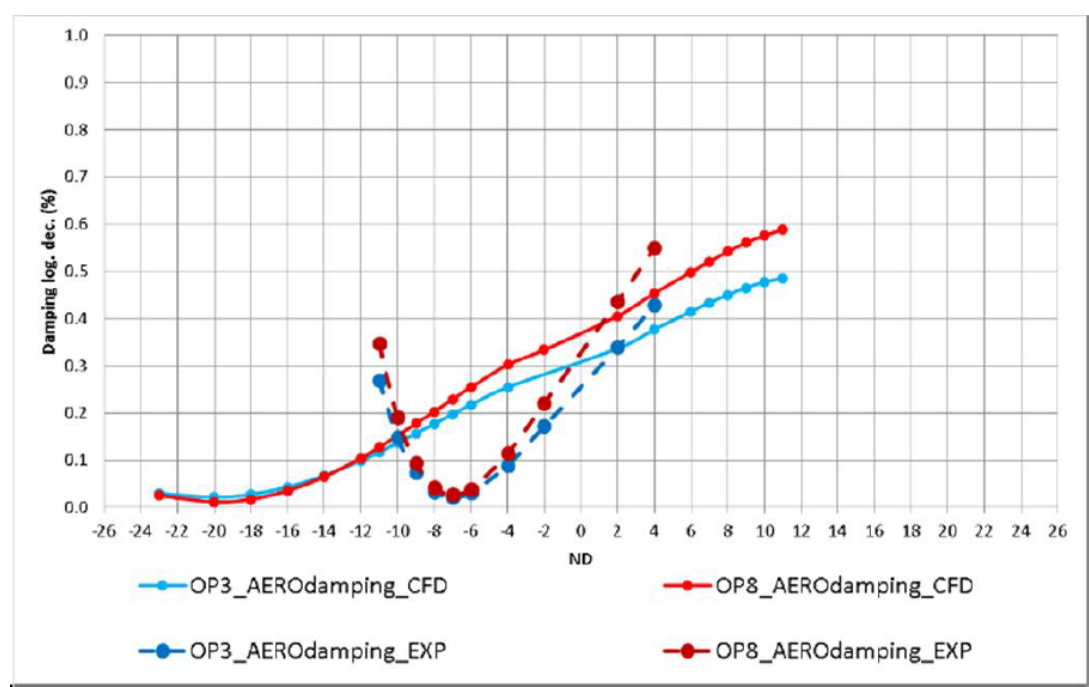
Figure 16. Aerodynamic damping in OP3 and OP8: comparison of experimental and numerical